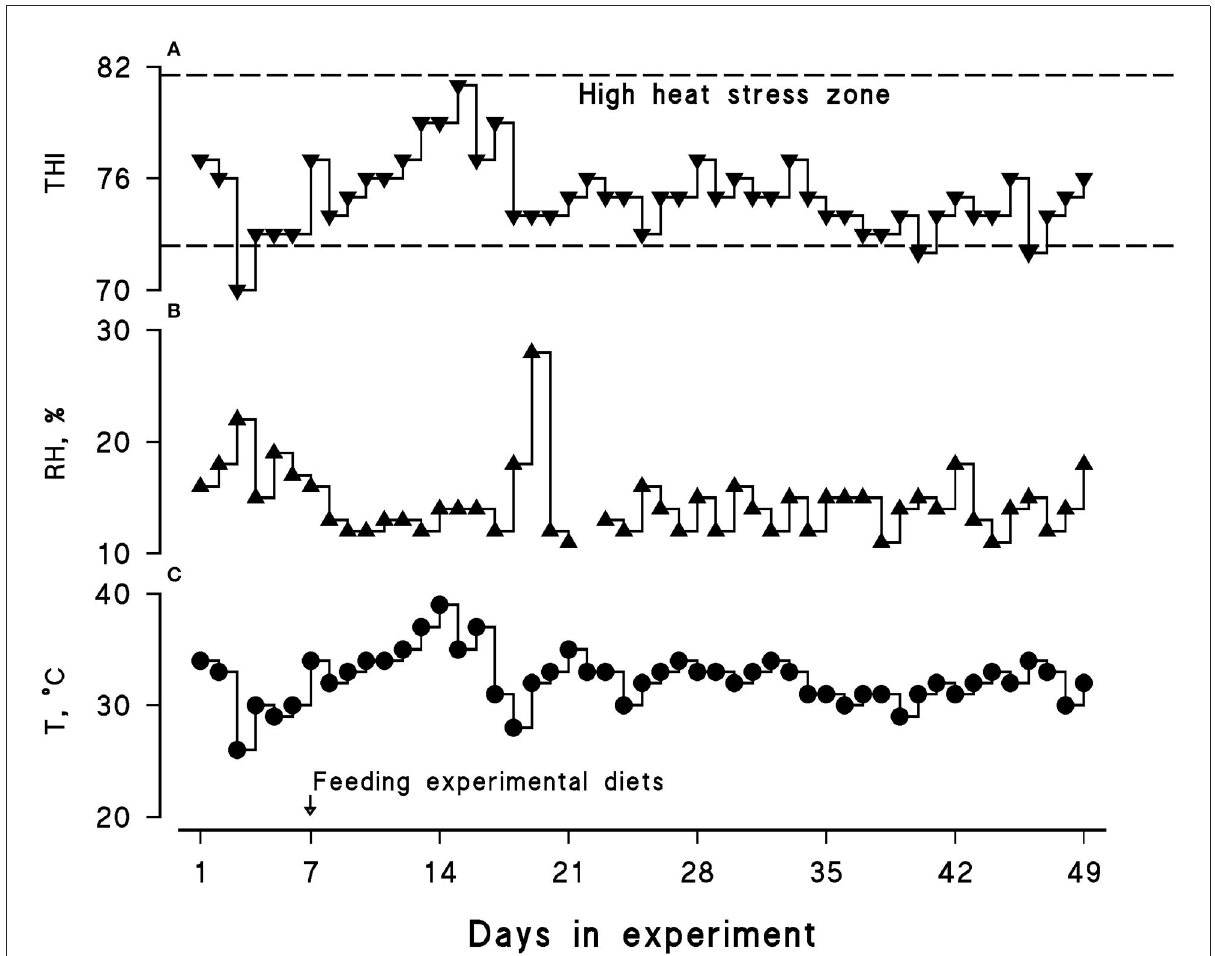
FIGURE1 Calculated temperature–humidity index (THI; A ) along with recorded relative humidity (RH, %; B ) and maximum ambient temperature (T, ◦ C; C ) during the course of the experiment (July–August, 2021). The daily maximum THI was calculated using the following equation: THI = (1.8